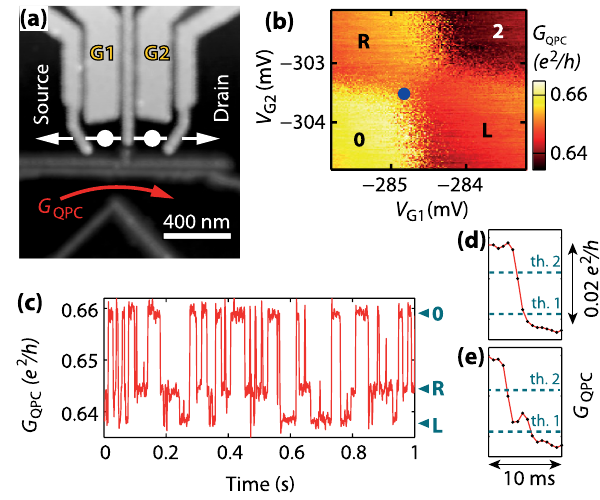
FIG. 1. (a) Atomic-force micrograph of the sample. Electrons can travel between the source and drain via the two quantum dots marked by disks. The conductance G QPC of the quantum point contact serves to read out the charge state of the quantum dots. (b) By using the two gates G1 and G2, the charge state of the sample is controllably switched between empty (0), singly occupied [left (L), right (R)], and doubly (2) occupied. These four states are visible as panels of distinct G QPC in the plot. (c) Time dependence of G QPC close to the charge-degeneracy point marked by a dot in (b), displaying fluctuations between three levels: L, R, and 0. (d) and (e): G QPC time segments showing examples (d) of a direct transition from 0 to L, and (e) of a transition from 0 to L via